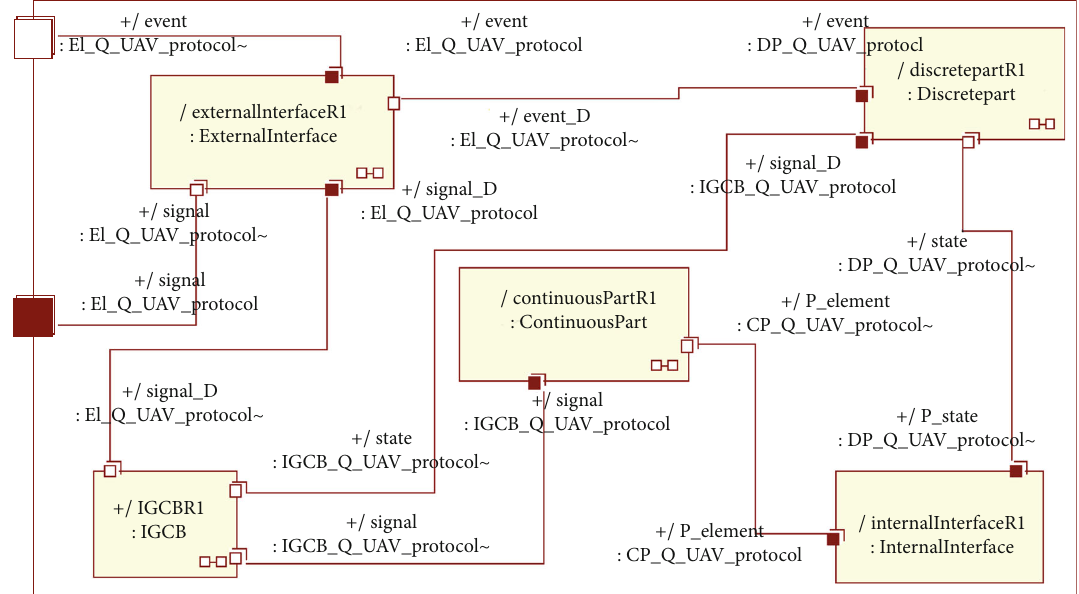
Figure 6: Collaboration diagram of the real-time capsule pattern for the Q-UAV